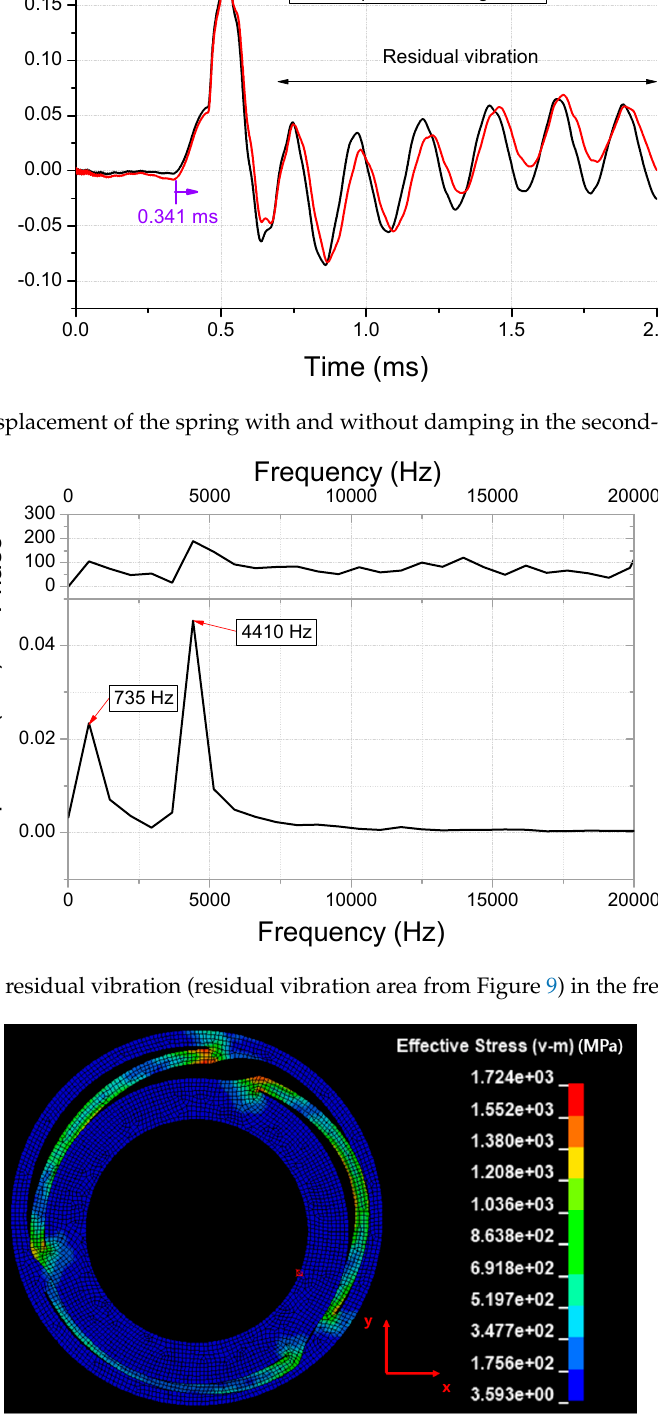
Figure 12. Effective stress of haptic spring at the moment of impact. Figure 12. E ff ective stress of haptic spring at the moment of